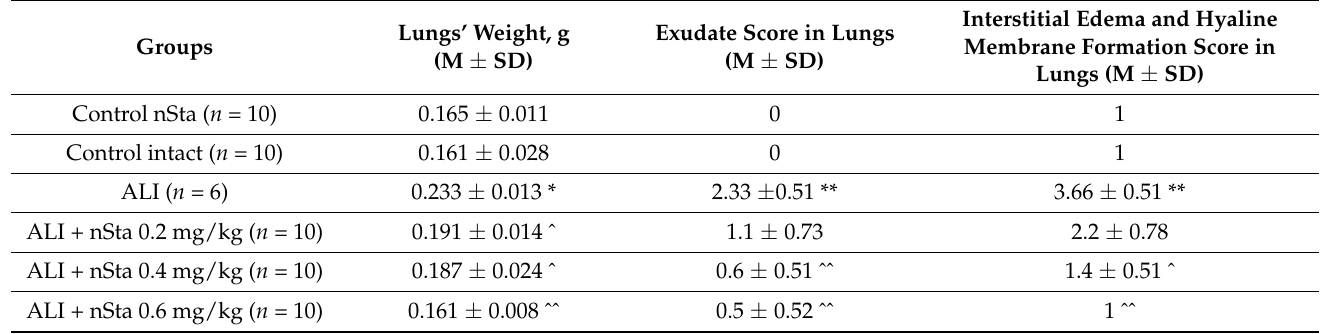
Table 3. Weights and morphological characteristics of the lungs of experimental